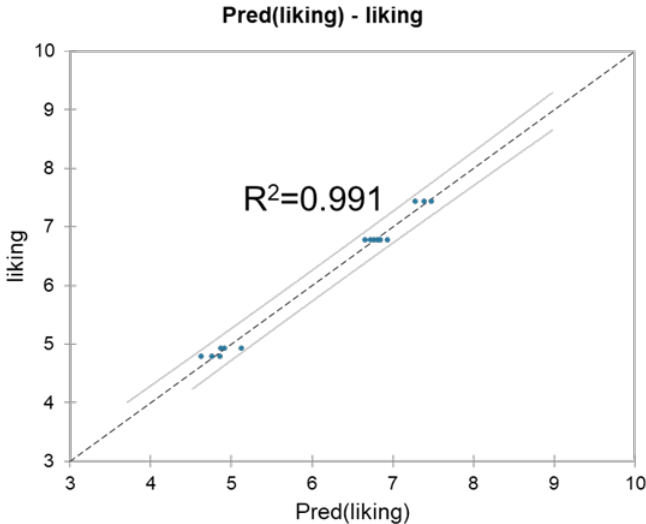
Figure 2. Correlation between actual and predicted mean scores for consumer liking.